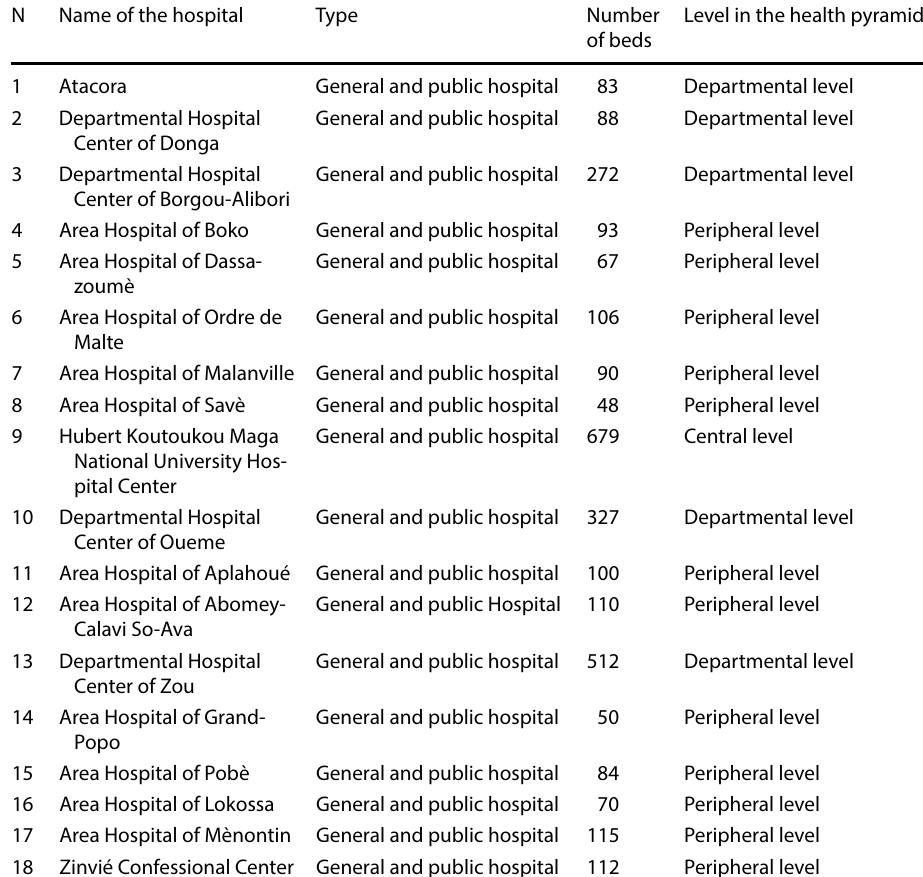
Table 1 Specification of sampling sites (hospital)